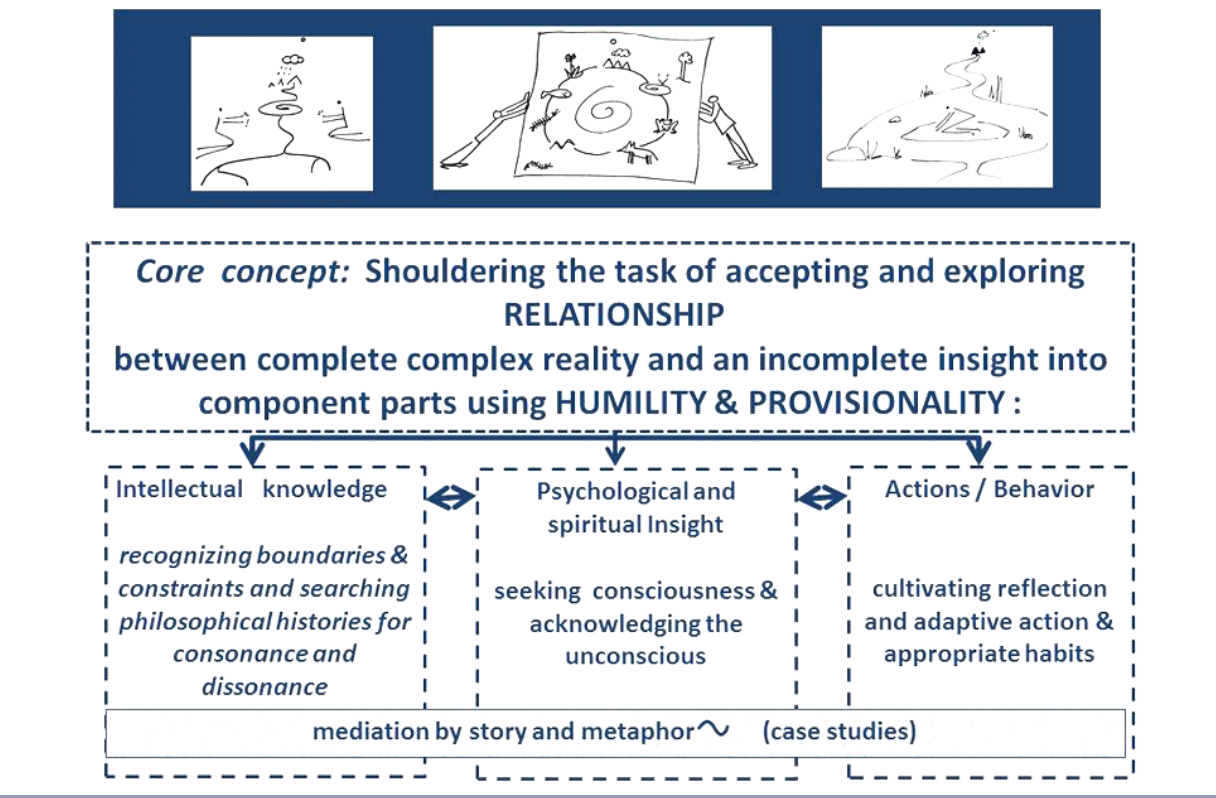
Fig. 1 . A representation by guest editor, Carolyn Palmer, of the perspectives presented in the special feature. The elements were derived from an early draft of the paper by Cilliers et al.